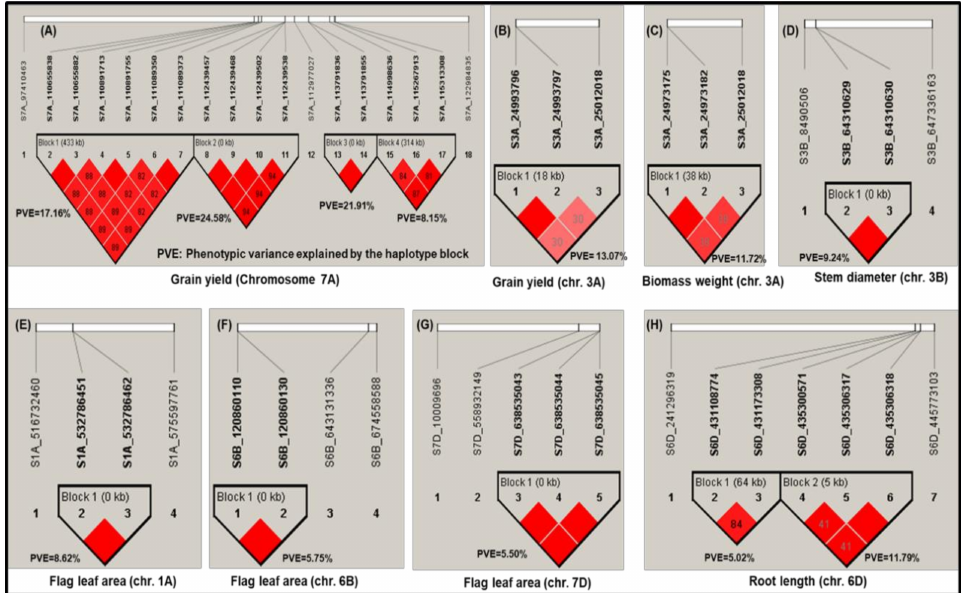
Figure 3. Linkage disequilibrium (LD) values (R 2 ) and haplotype blocks with significant marker–trait associations (MTAs; ≥ 2) observed ( A ) on chromosome 7A for GY, ( B ) on chromosome 3A for GY, ( C ) on chromosome 3A for BMWT, ( D ) on chromosome 3B for STMDIA, ( E ) on chromosome 1A for FLA, ( F ), on chromosome 6B for FLA, ( G ) on chromosome 7D for FLA, and ( H ) on chromosome 6D for RTLN and phenotypic variance explained (PVE) by each haplotype block. Dark red color represents the strong LD whereas light red color represents the weak LD between pairs of MTAs.